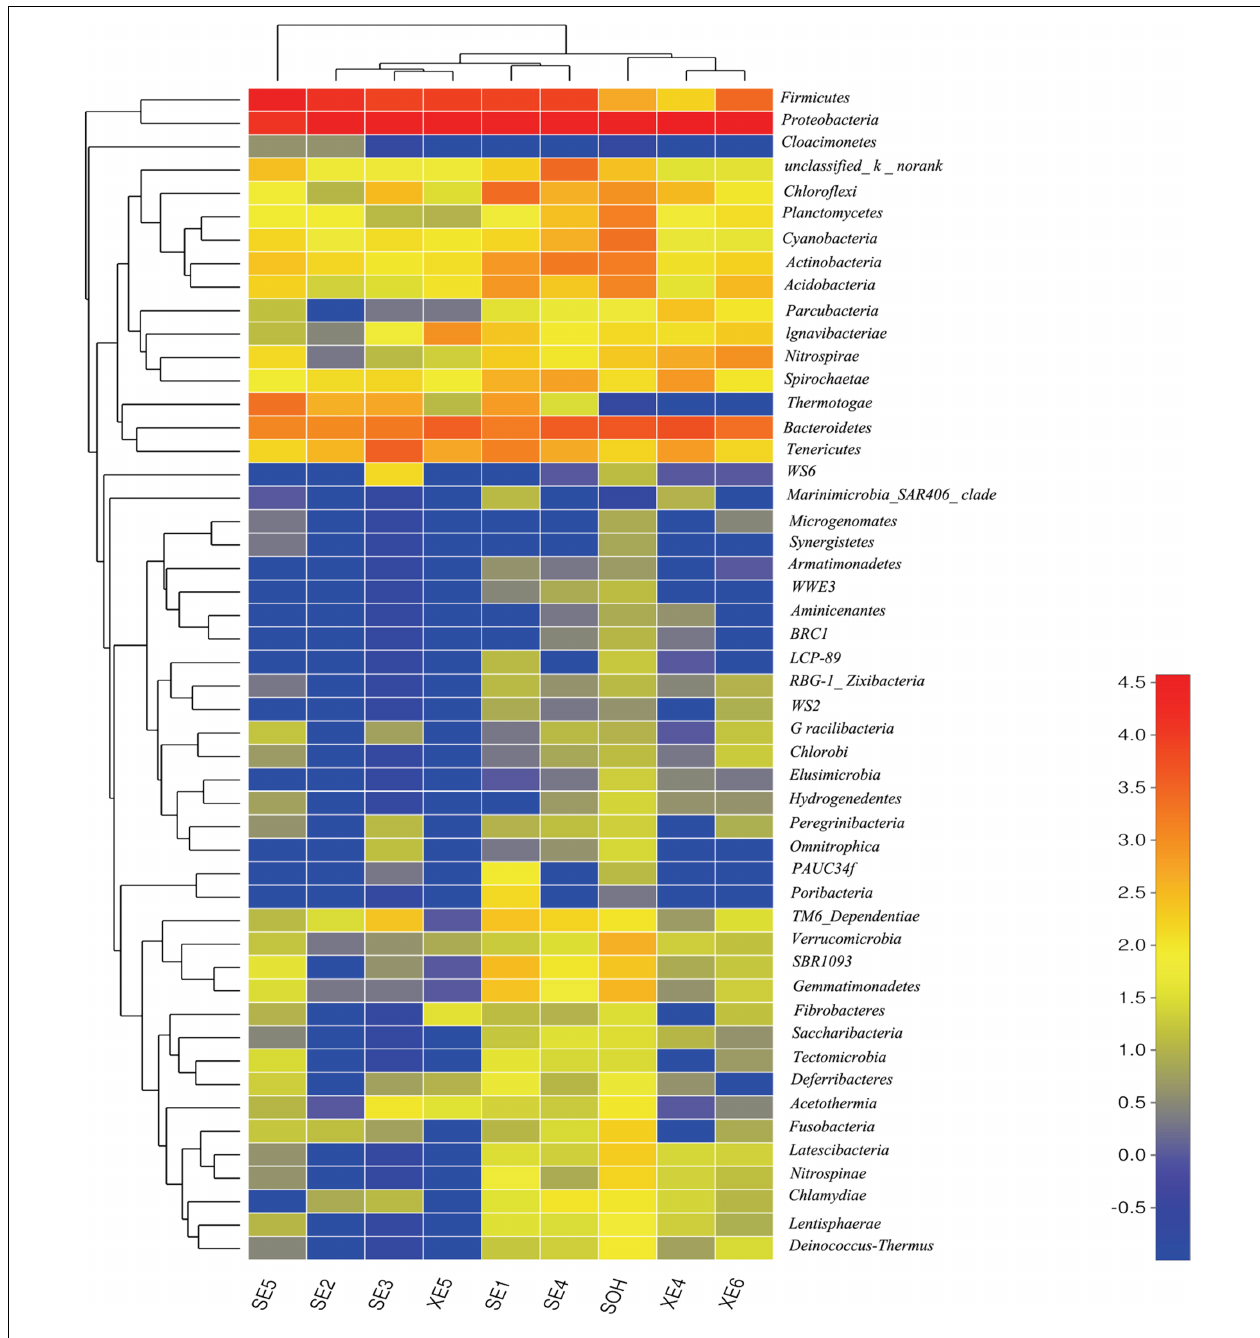
FIGURE 4 | The bacterial community distributions among the nine corrosion samples at the phylum